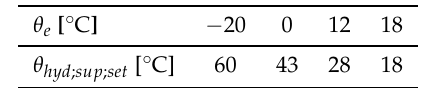
Table 4. Supply temperature look-up table, used for both IDA ICE and ISO14N models.